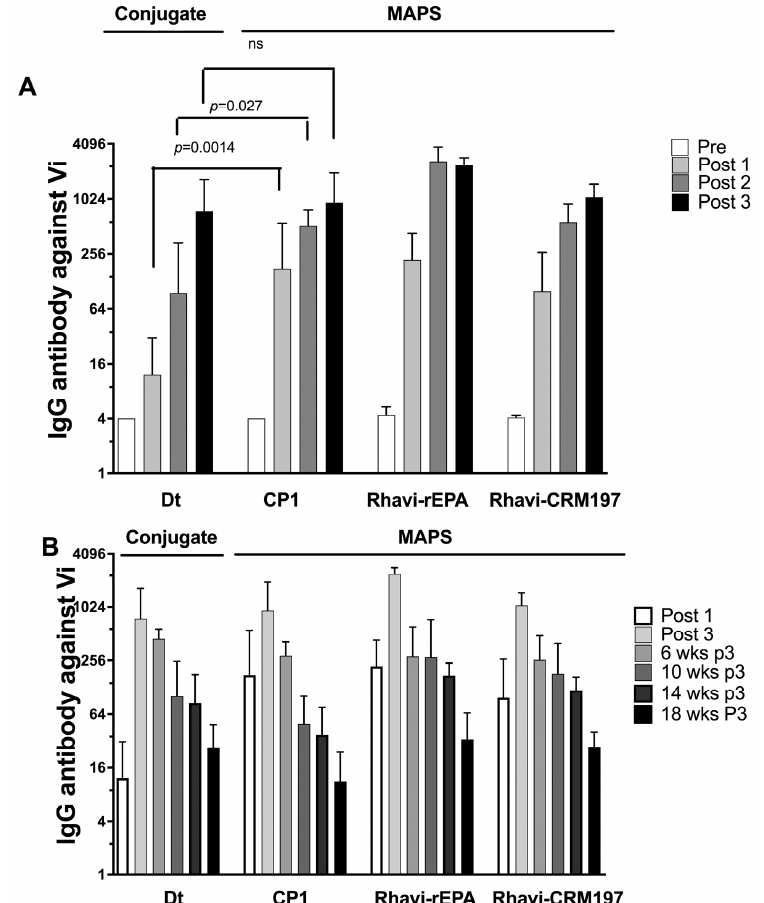
Figure 2. Immunogenicity of Vi conjugate or Vi MAPSs in guinea pigs. ( A ). Vi IgG titer from Dt-Vi conjugate, CP1-Vi, Rhavi-rEPA-Vi and Rhavi-CRM197 MAPS immunized Guinea pigs. ( B ). Vi IgG titer kinetics after the last immunization. Each group contained ten Guinea pigs. Bars showed geometric mean antibody titers and 95% confidence intervals. ns, non-significance.